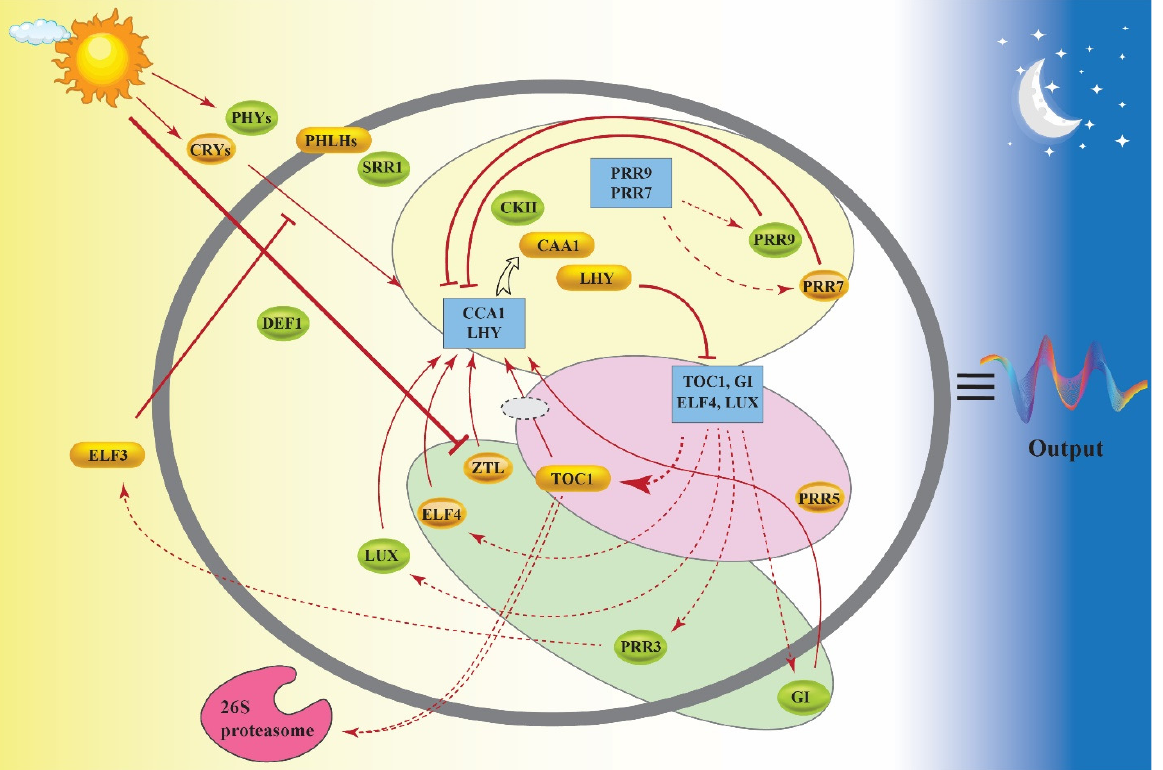
Figure 1. Feedback loops within the internal oscillators. Pink loop: the transcriptional feedback loop contains the morning-phased transcription factors CCA1 and LHY, and negatively regulates TOC1. Yellow loop: consists of PRR7, PRR9, CCA1, and LHY. Green loop: represents ZTL, which is the negative regulator of TOC1, also regulated by the establishment of GI and PRR3. (Rectangles: genes; Ovals: proteins; Dashed lines: transcription/translation; Solid lines: protein activity; Lines ending in arrows: stimulatory function; Dashes: negative action of the corresponding proteins).